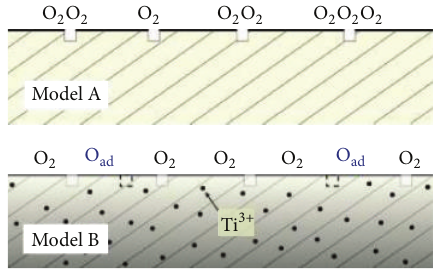
Figure 11: The schematic diagram for the influences of OTDs on O 2 adsorption. Model A: O 2 adsorption on surface OTDs and Model B: surface oxygen distribution influenced by surface and bulk OTDs [103].